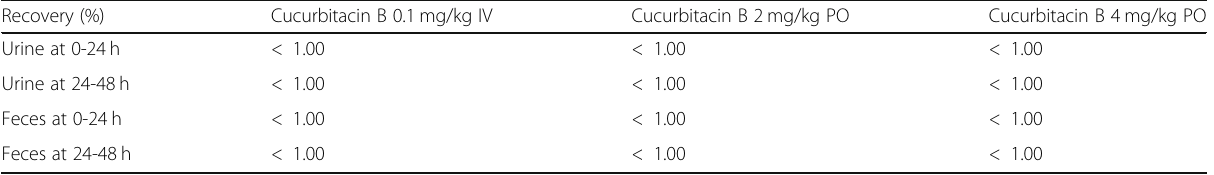
Table 7 The percent recovery of unchanged cucurbitacin B in excreta compared to administered dose Recovery